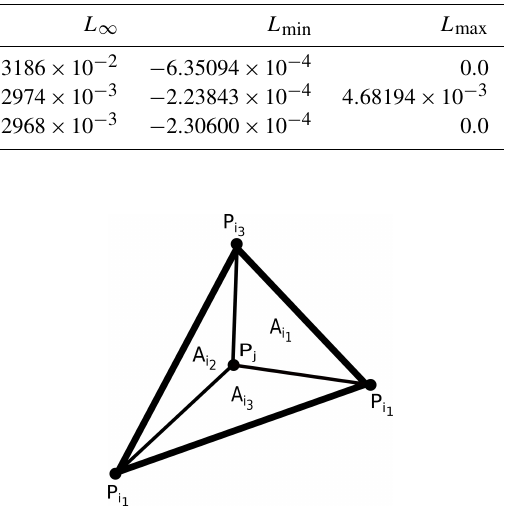
Figure 9. The weights used in the weighting based on the Delaunay